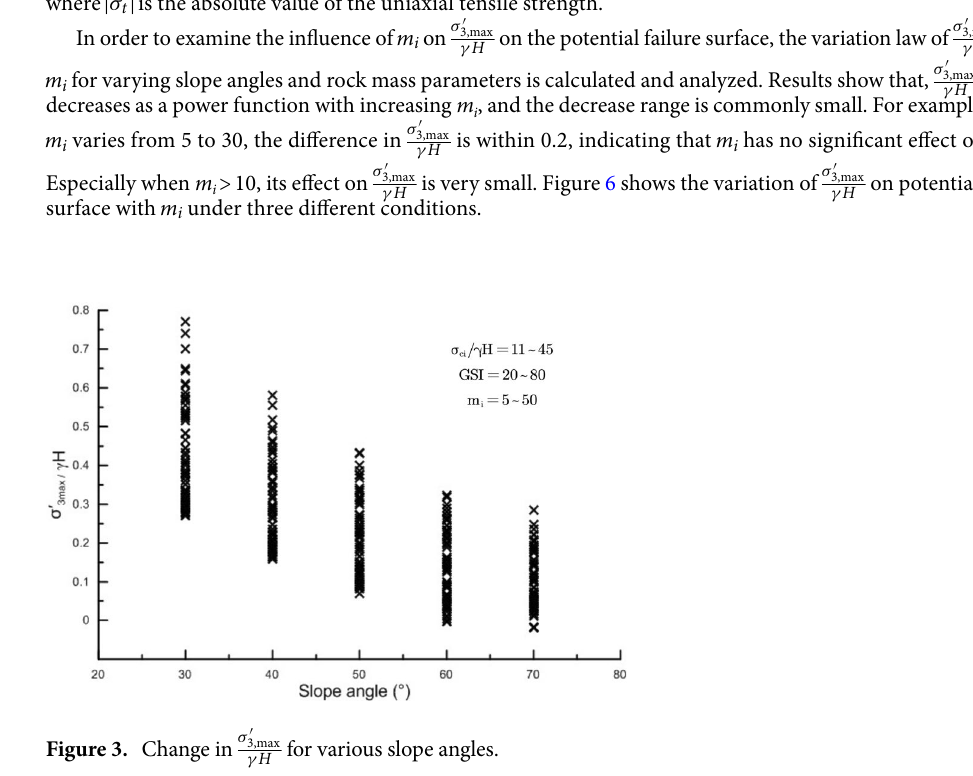
Figure 3. Change in